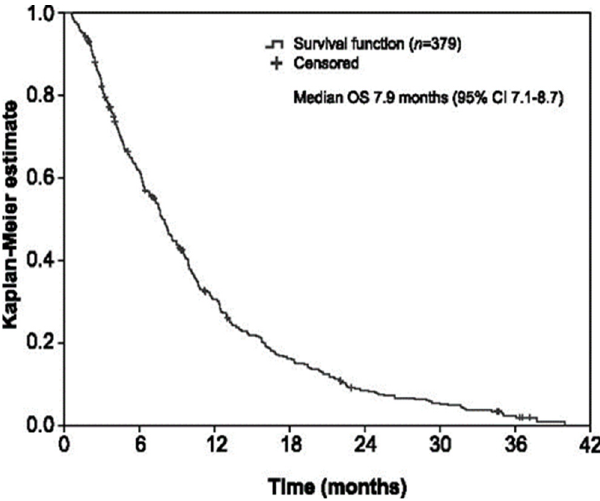
Figure 1. Kaplan–Meier plot for overall survival. CI: confidence interval, OS: overall survival. Table 3. Patient characteristics associated with overall survival in multivariate Cox analyses.